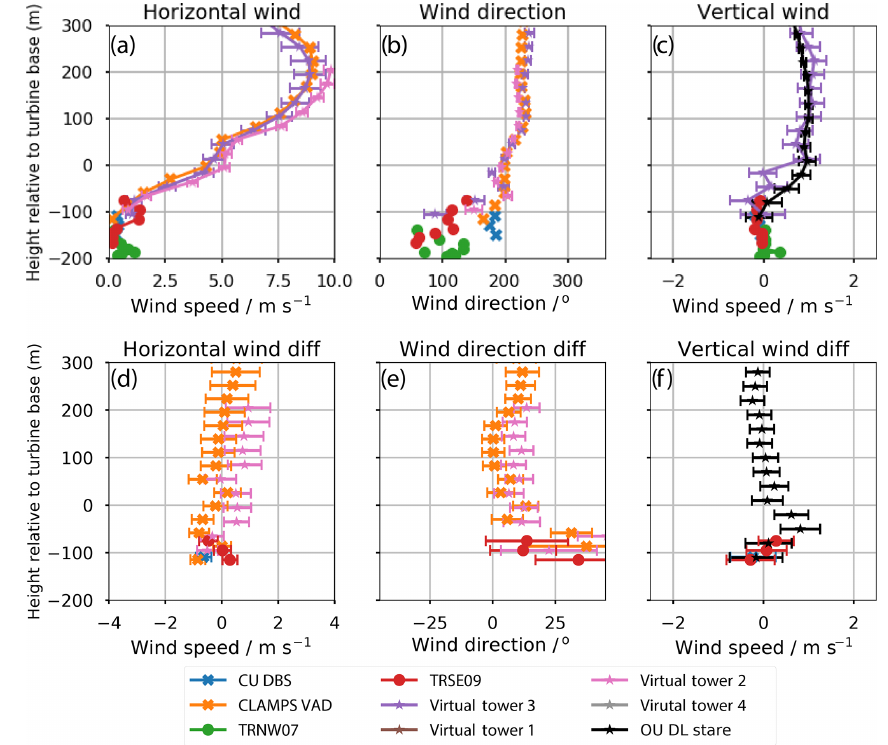
Figure 8. Same as Fig. 6 but for 14 June at 02:58UTC when higher vertical velocities were